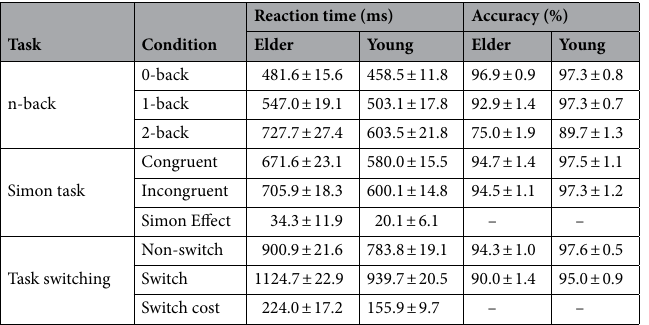
Principal component analysis for executive function components. PCA was conducted based on the measures of cognitive tasks in order to generate more reasonable, structured components representing the abilities of execu- tive functions, and thus to show clearer correlation with takeover behaviors. The subject to item ratio in our study is 7.78:1 (70 participants in total and 9 measures from different tasks), which is larger than the commonly recommended minimum subject to item ratio of 5:1 72 .The PCA results of the selected measures of performance in EF tasks (normalized data) are shown in Table 2. The measures comprised RTs and accuracy results for the tasks. Accuracy in the 0-back condition was not selected because the differences between individuals and groups were not significant. The measures for RTs in the Simon task and task switching was chosen as the Simon effect and switch cost in each task. The loadings for each component are presented in Table 2. The principal components were ordered by their percent of variance explained. The results showed that PC1–PC4 had eigenvalues greater than one. As for PC5, despite the eigenvalue of 0.87, the difference of percentage of variance explained between PC4 (11.4%) and PC5 (9.6%) was not evident, yet the decrease between PC5 and PC6 (6.3% of variance, 0.57 of eigenvalue) was sharp. Considering the per- centage of variance explained, PC4 and PC5 both accounted for about 10% of the variance individually, and by including PC5 there were over 80% (82.30%) of cumulated variance. Therefore, we chose the first 5 components in percent of variance and yielded a five-component solution for further analyses. The interpretation of the main composition of each principal component and the EF components is shown in Table 3. Driving performance. Driving performance was evaluated by the standard deviation of the steering wheel angle (sdSteer) during the manual driving period, and the TTC at the moment of the lane change. Outliers were identified as observation points outside 1.5 * Inter Quartile Range, which was the difference between the 75th and 25th quartiles of the dataset. The observations higher and lower than the boundary were replaced by the higher and lower limits of the values of the 95th and 5th percentiles of the dataset. The differences between the groups and conditions are presented in Fig. 3.